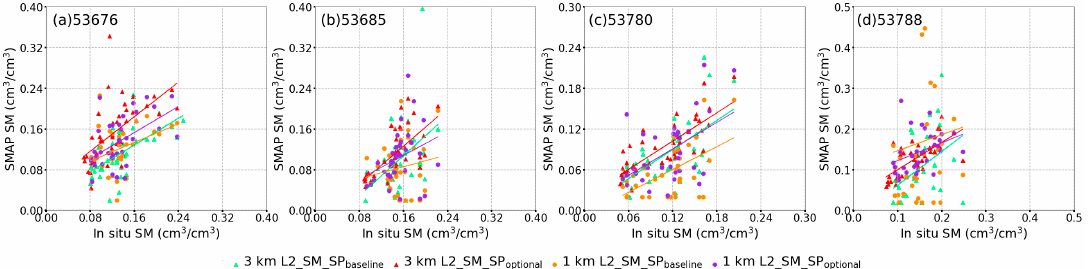
Figure 6. Scatterplots of the SMAP L2_SM_SP products (3 km and 1 km) vs. the in situ SM at the four SM stations. Table 4. Results comparison summary of the L2_SM_SP products (3 km and 1 km) vs. in situ SM. The number of samples at stations 53676, 53685, 53780, and 53788 was 36, 37, 34, and 33, respectively. Avg is short for average.